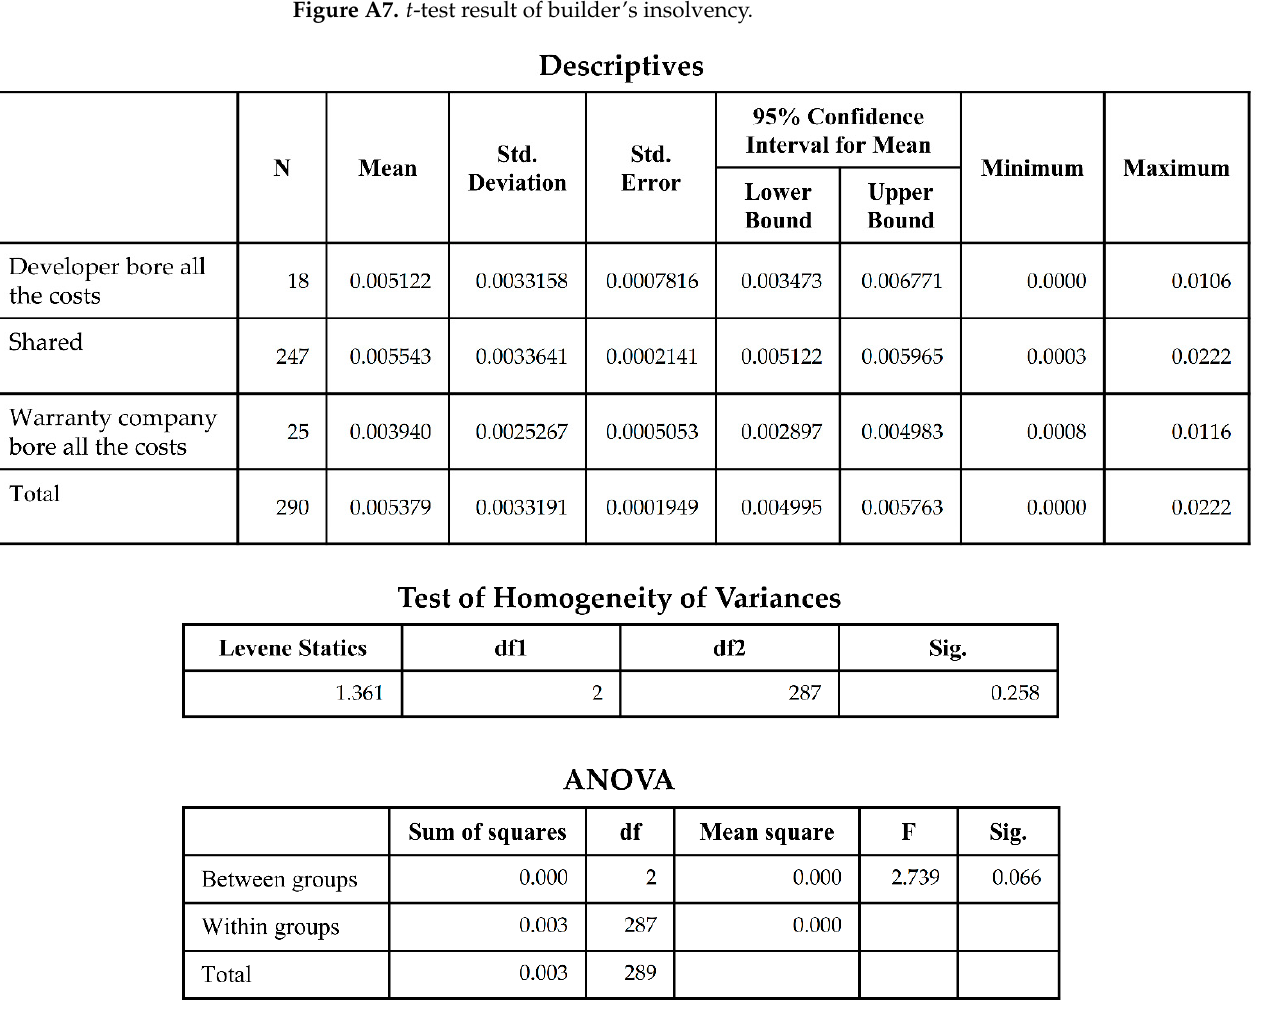
Figure A8. ANOVA result of damage sharing to project